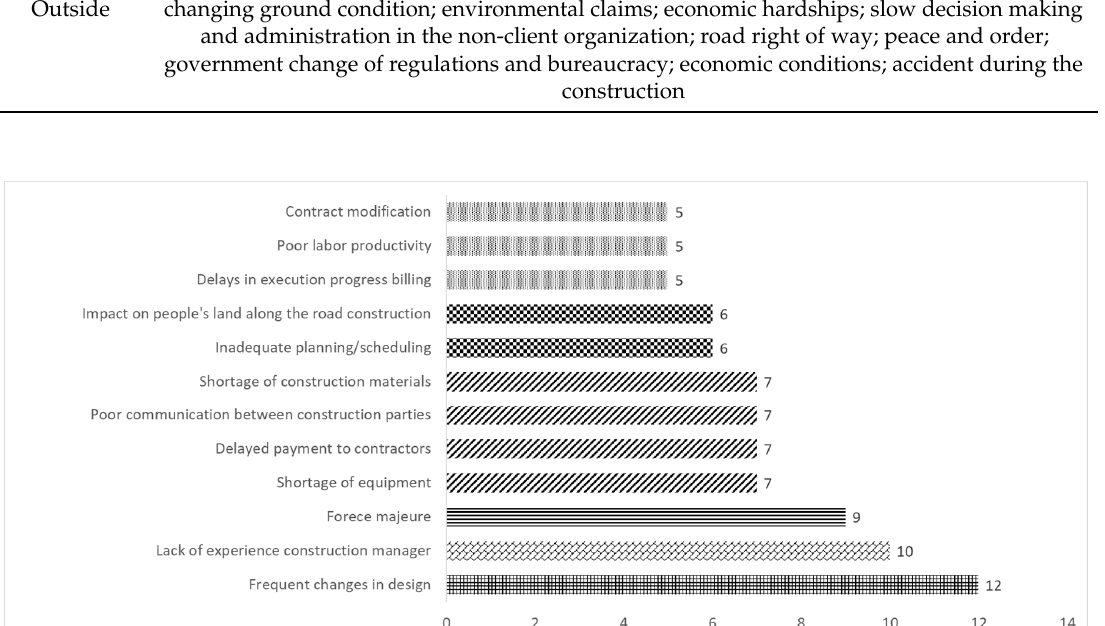
Figure 1. Frequent delay causes.